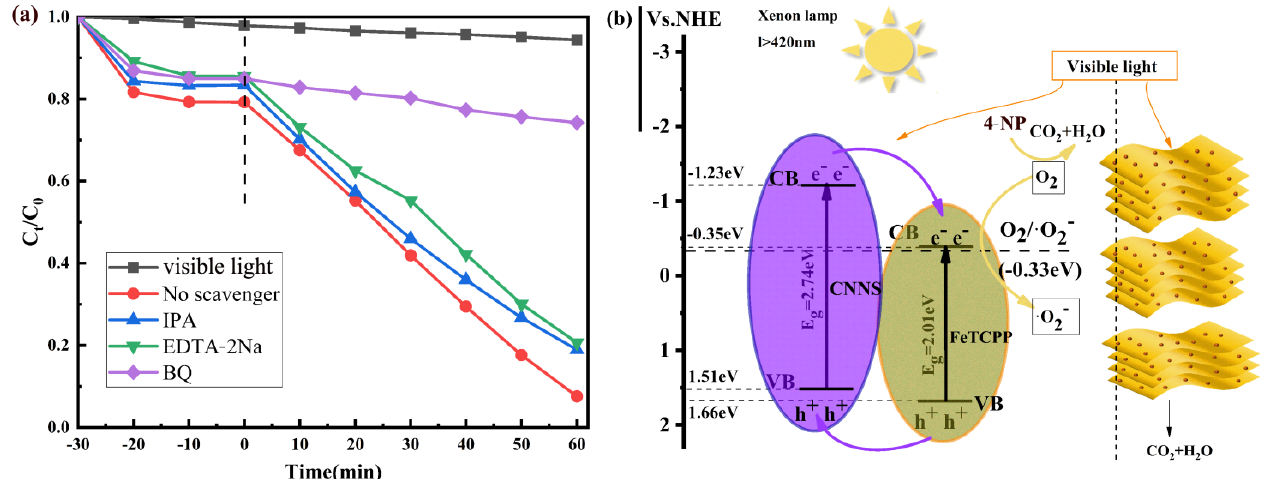
Figure 10. ( a ) Active substance capture experiment of 3% FeTCPP@CNNS photocatalyst under visible light irradiation and ( b ) photocatalytic mechanism of FeTCPP@CNNS photocatalyst under visible light irradiation.